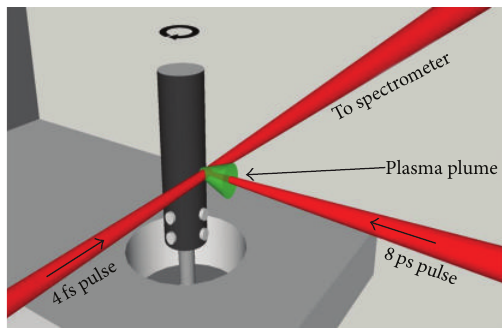
Figure 6: Schematic of the rotating target and HHG configuration [37].